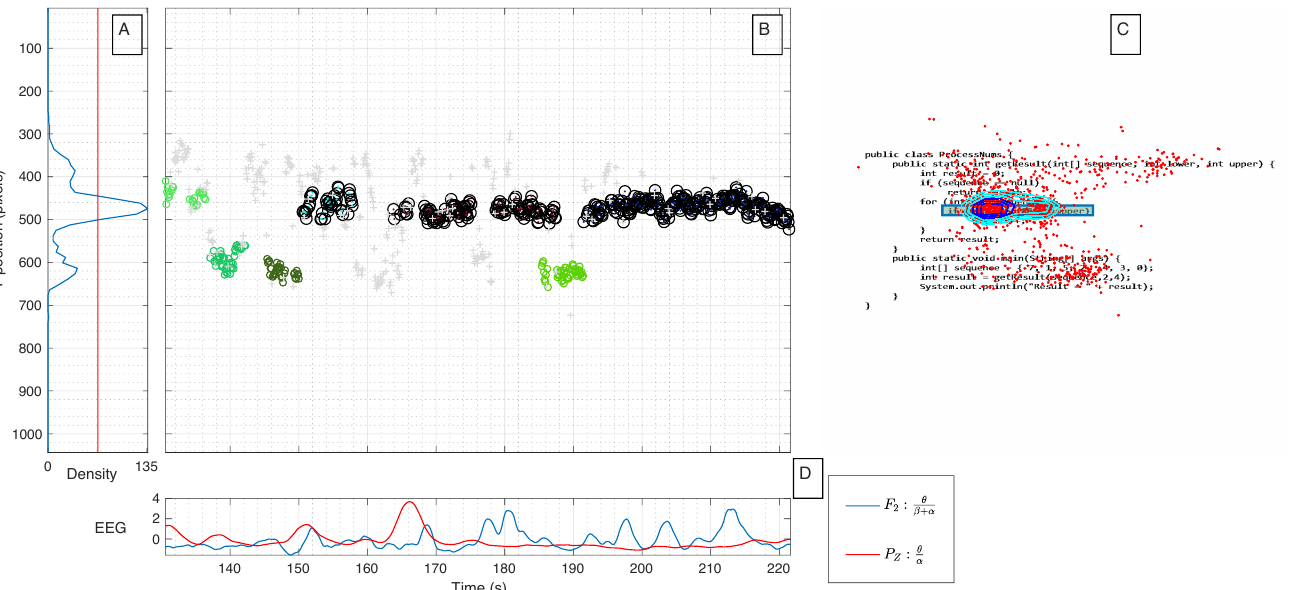
Figure 10. Example of the fusion of EEG with eye tracking, for an intermediate participant during Code task 1. ( A ) Density of gaze points with the red line as a reference of 50% of the maximum row density; ( B ) clusters of gaze points over time and the y-axis; ( C ) code task figure overlapped with gaze points; and ( D ) discriminant EEG features values over time.